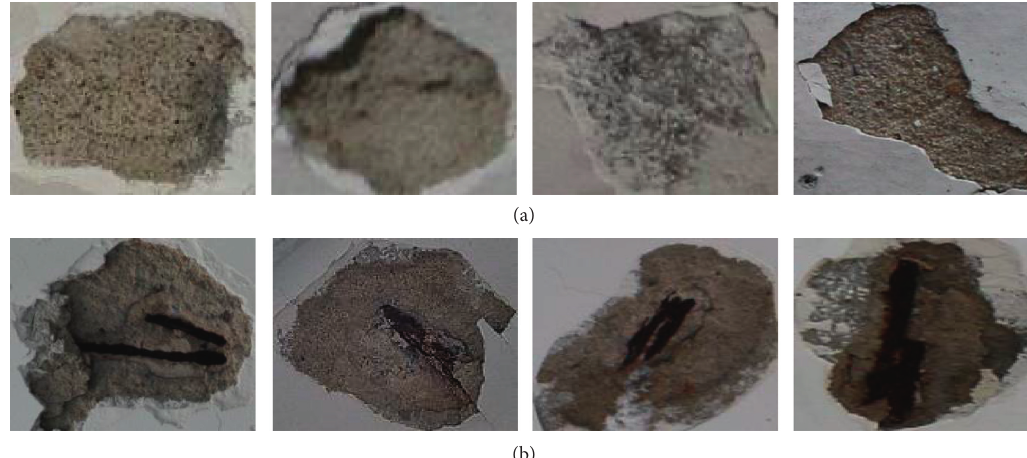
Figure 1: Appearances of spall in reinforced concrete surface: (a) shallow spall and (b) deep